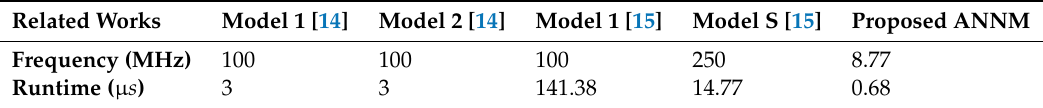
Table 11. Runtime Comparison with related